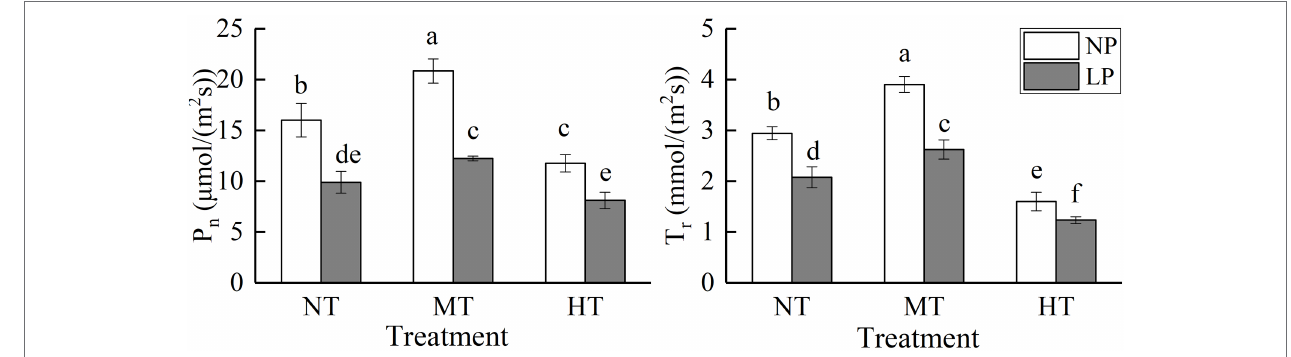
FIGURE 4 | Effect of root zone temperature and phosphorus content on the net photosynthetic rate (Pn) and the transpiration rate (Tr). NT: 24 ° C, MT: 30 ° C, and HT: 36 ° C (root zone temperature); LP: 1.25 μ m and NP: 250 μ m (phosphorus content). Notations above bars of a, b, c, d, e, and f indicate homogeneous groups ( α =